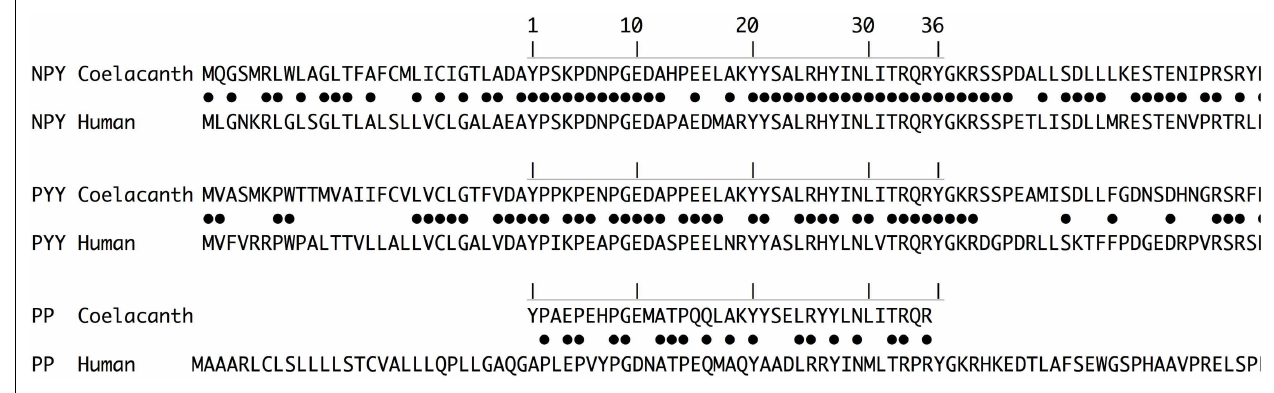
FIGURE 4 | Pairwise prepropeptide sequence alignments between coelacanth and human for NPY, PYY, and PP (pancreatic polypeptide). Identical positions are marked with dots for each pairwise comparison.The mature peptide sequences are marked with the horizontal line and the positions are numbered 1 through 36.